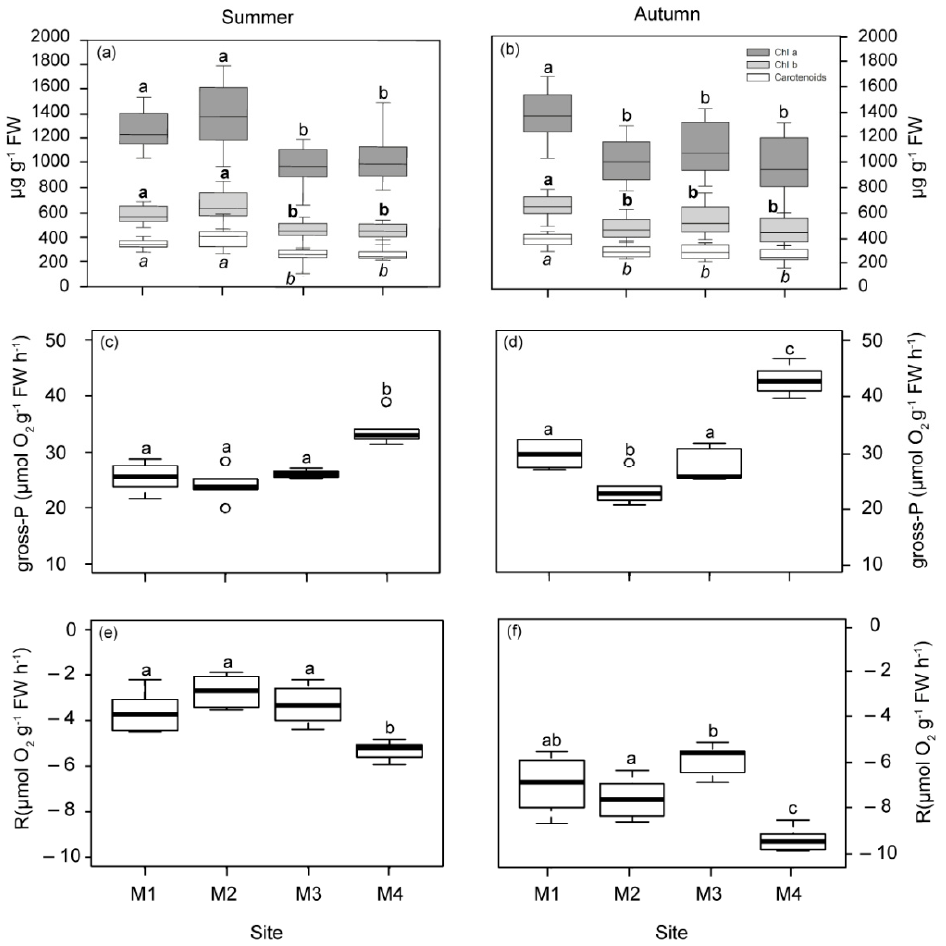
Figure 2. Pigment content and photosynthetic parameters measured in plants from the four studied deep meadow sites (M1–M4) in summer and autumn (left and right, respectively). Chlorophyll a , b and carotenoids (( a , b )), gross photosynthesis (gross-P; ( c , d )), respiration rates (R; ( e , f )). Different letters denote significant differences among sites (Tukey test, p < 0.05).